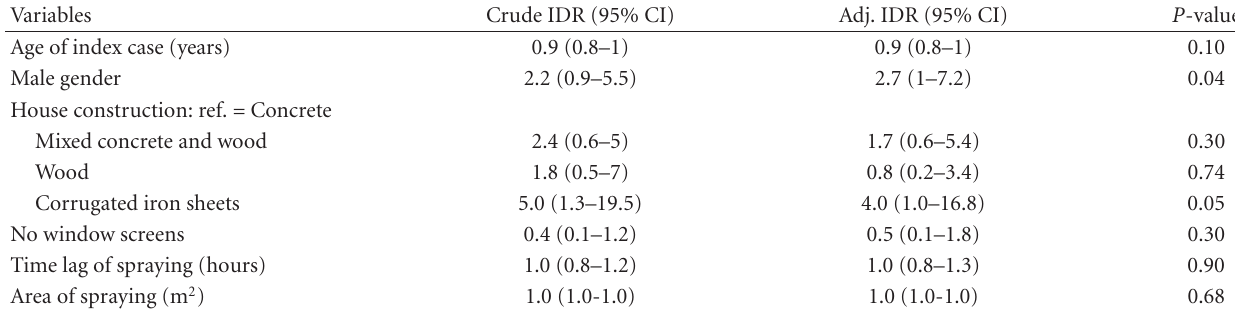
Table 6: Multivariate analysis of factors a ff ecting incidence of secondary